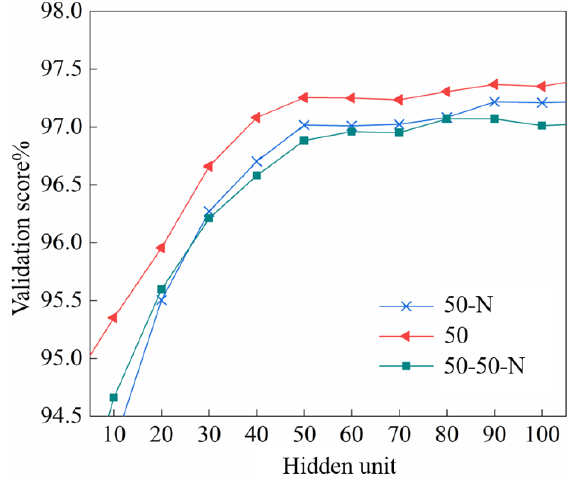
Figure 6. Relationship between the number of hidden units and the validation score.